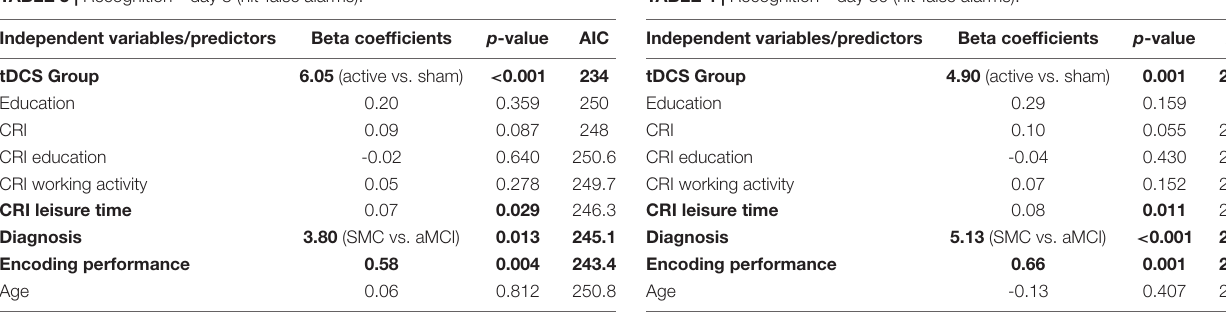
TABLE 3 | Recognition—day 3 (hit-false alarms). TABLE 4 | Recognition—day 30 (hit-false